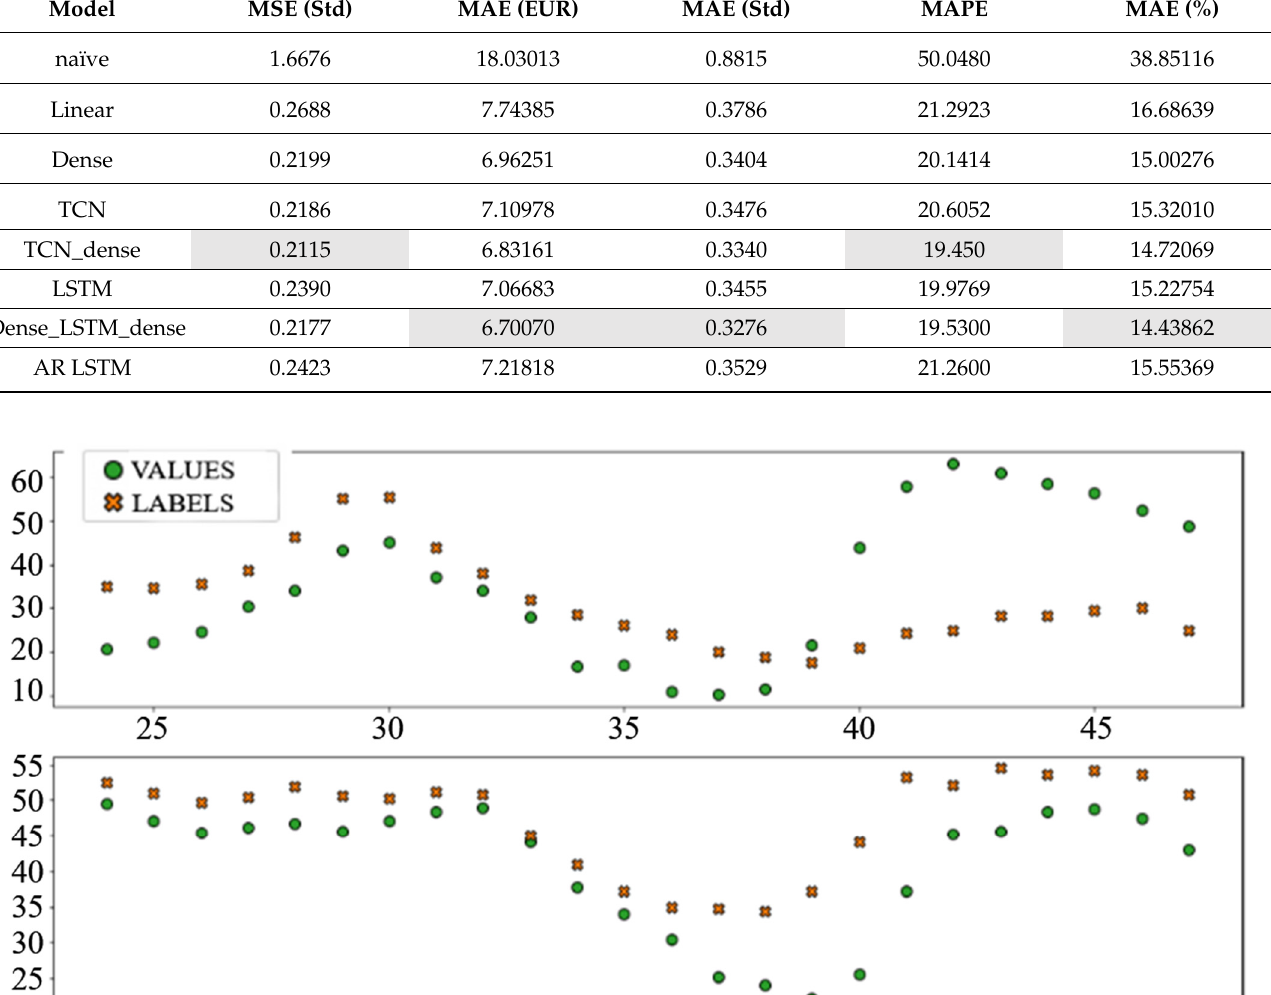
Table 3. Performance of models for electricity price prediction.